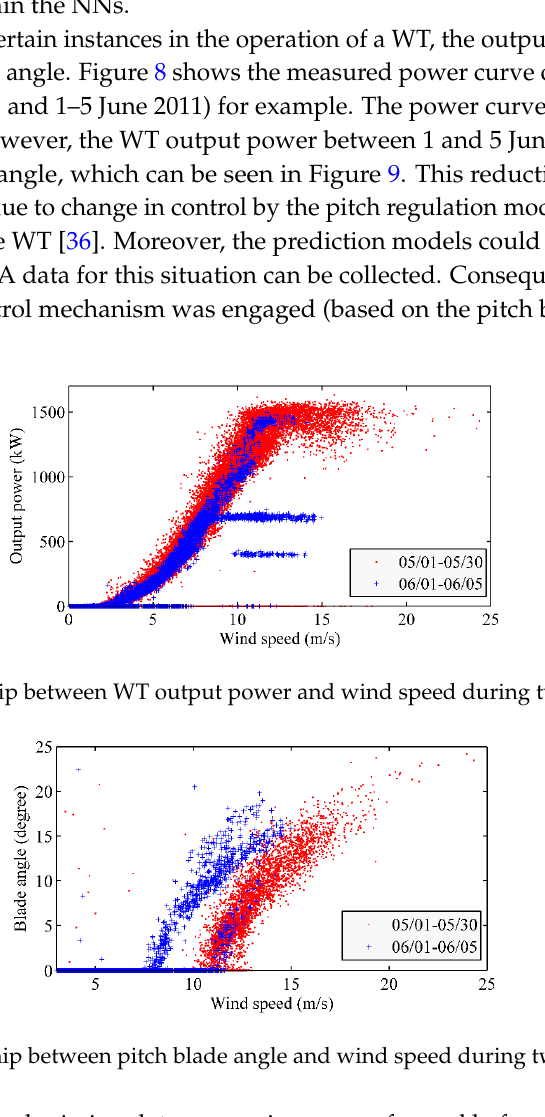
Table 3. Data sampling for the prediction models of Type 1 parameters.